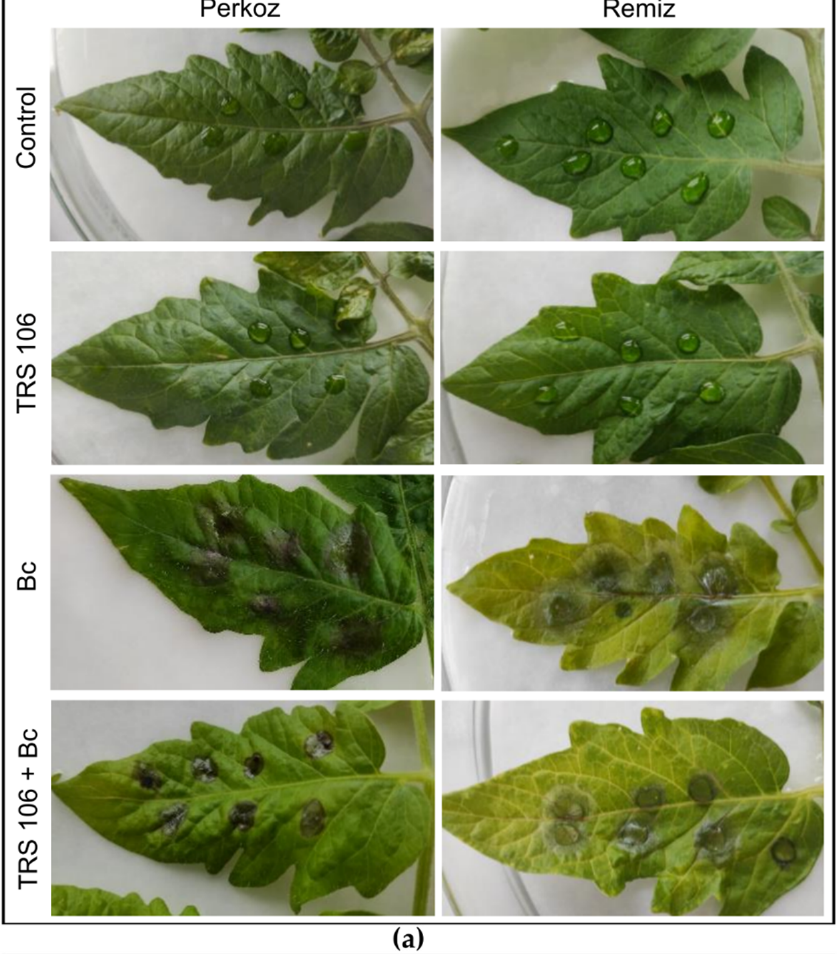
Figure 2. ( a ) Effect of TRS 106 on the tomato plants protection against B. cinerea . Evaluation of the disease symptoms, i.e., irregular brown lesions, dark brown blight blotches, and rot symptoms on leaves; ( b ) disease area on leaves, occurring on 5-week-old tomato plants caused by B. cinerea , 72 h after inoculation. Values represent the means + SE from four independent experiments with three replicates each (n = 12). Differences between cultivars within a given variant were analyzed with Student’s t -test and marked using letters A and B. Separately for each cultivation, differences be- tween Bc and TRS 106 plants were analyzed with Student’s t -test and marked using asterisk symbol (*** p < 0.001). Data points followed by a different letter are significantly different at p ≤ 0.05. Abbre- viations are as in Figure 1. Comparing the plants belonging to two tomato varieties, the area of infected leaves was greater in ‘Remiz’ than in ‘Perkoz’ plants. The most extensive disease area develop- ment was observed in Bc ‘Remiz’ plants, reaching on average 45 % of the leaf area (Figure 2b). The disease symptoms were significantly suppressed in plants belonging to both